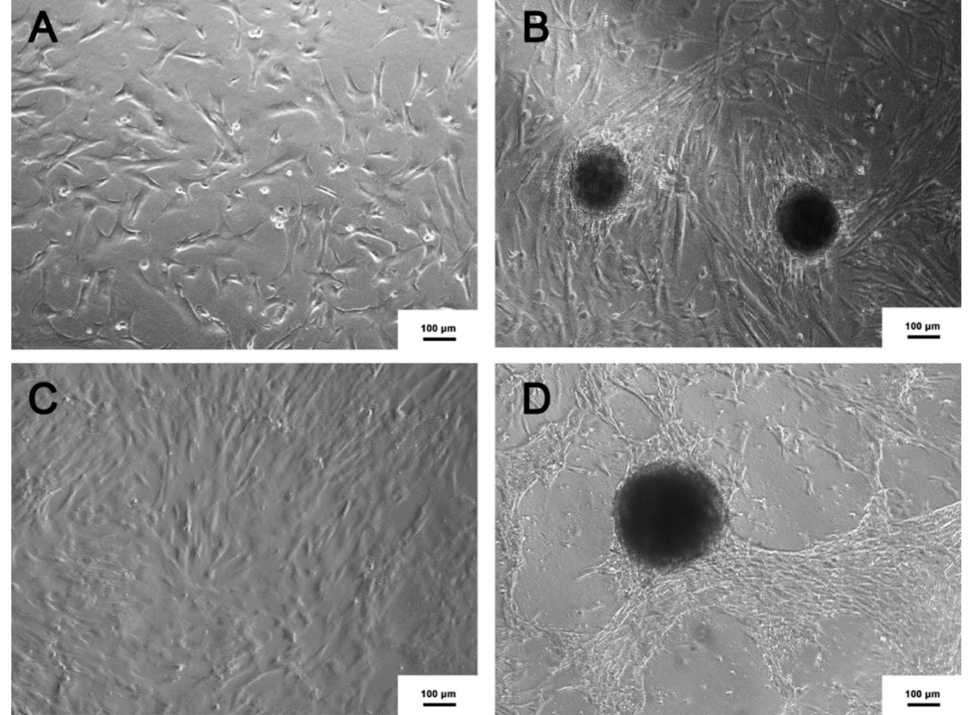
Figure 2. Neurospheres (NPCN+). ( A ) MSC-UCB seeded on polystyrene substrate ( B ) Neurospheres derived from MSC-UCB, seeded on NFBX. ( C ) MSC-WJ seeded on polystyrene substrate ( D ) Neuro- spheres derived from MSC-WJ, seeded on NFBX (Inversion optical microscope, ×